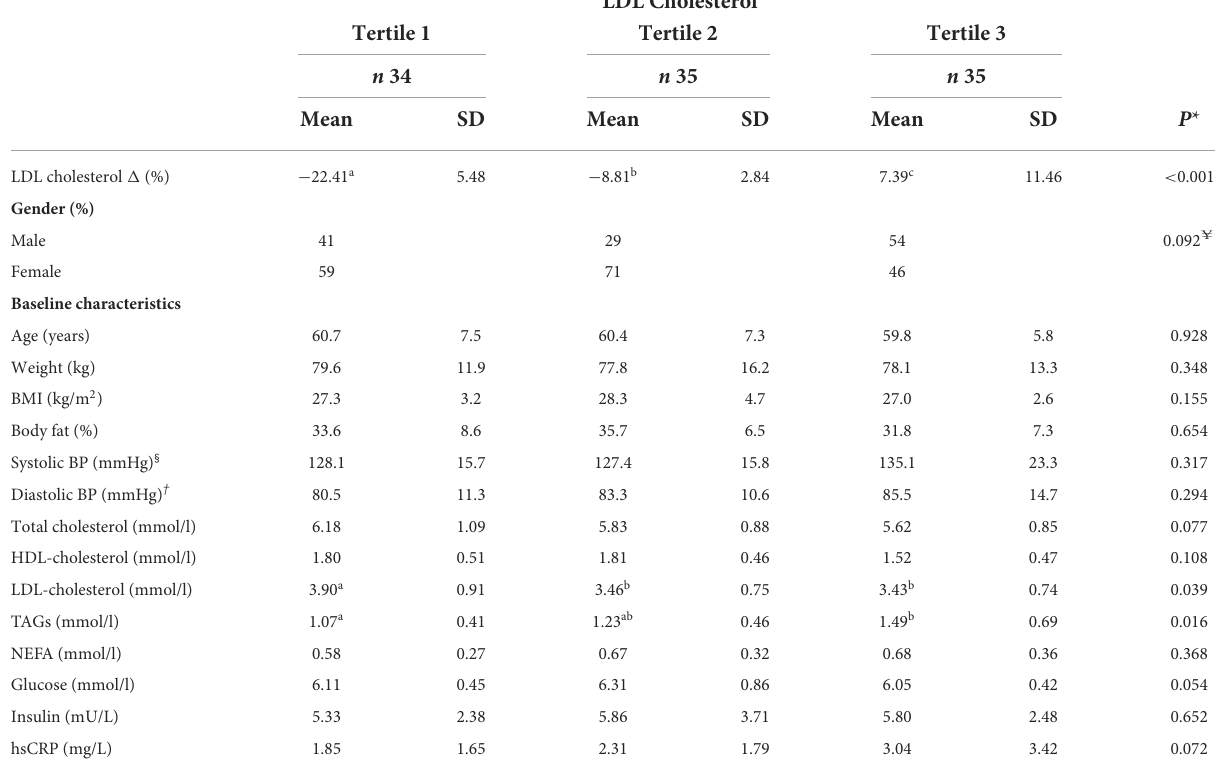
TABLE 3B Comparison of baseline characteristics across tertiles of percentage change in circulating serum LDL cholesterol levels for total